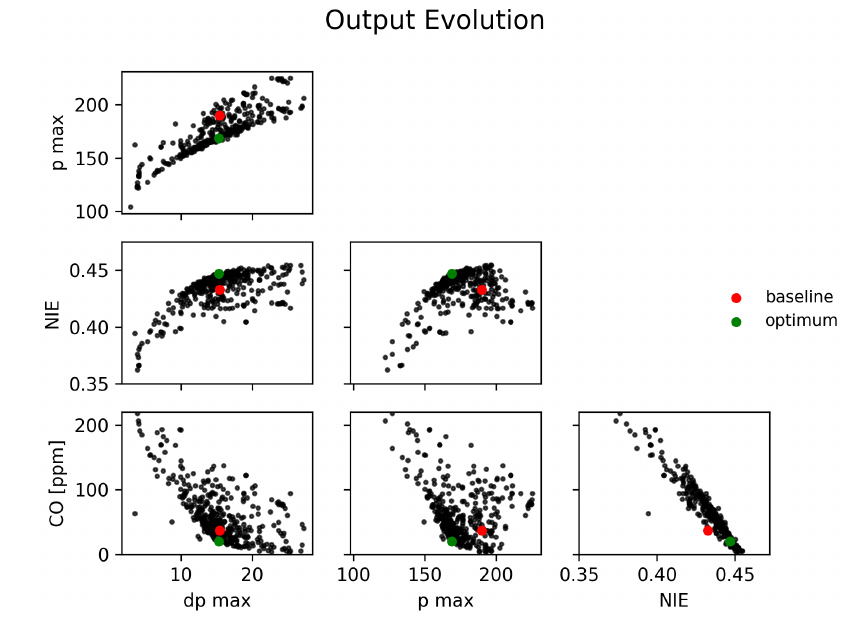
Figure 15. Evolution of particle output.